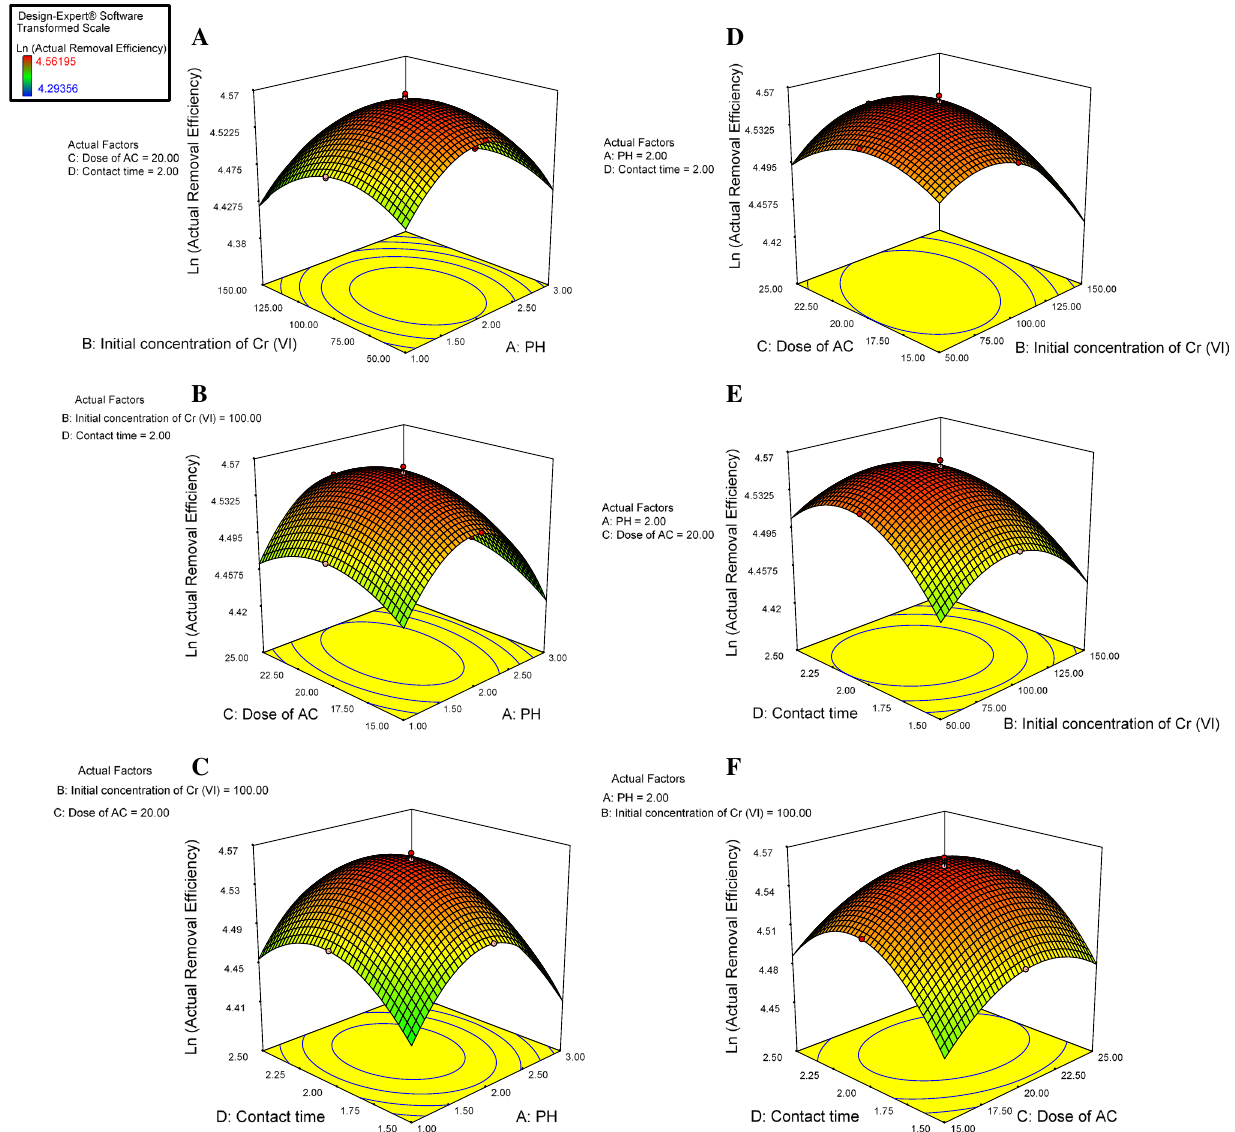
Fig. 3 3D response surface plot of combined effect of a PH and ini- tial concentration of Cr(VI). b PH and dose of activated carbon: on removal efficiency of THAC. C) PH and contact time. D) Initial con- centration of Cr(VI) and dose of activated carbon on removal effi-